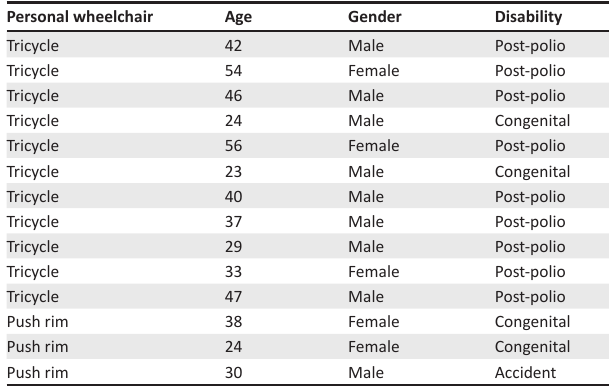
TABLE 1: Participant